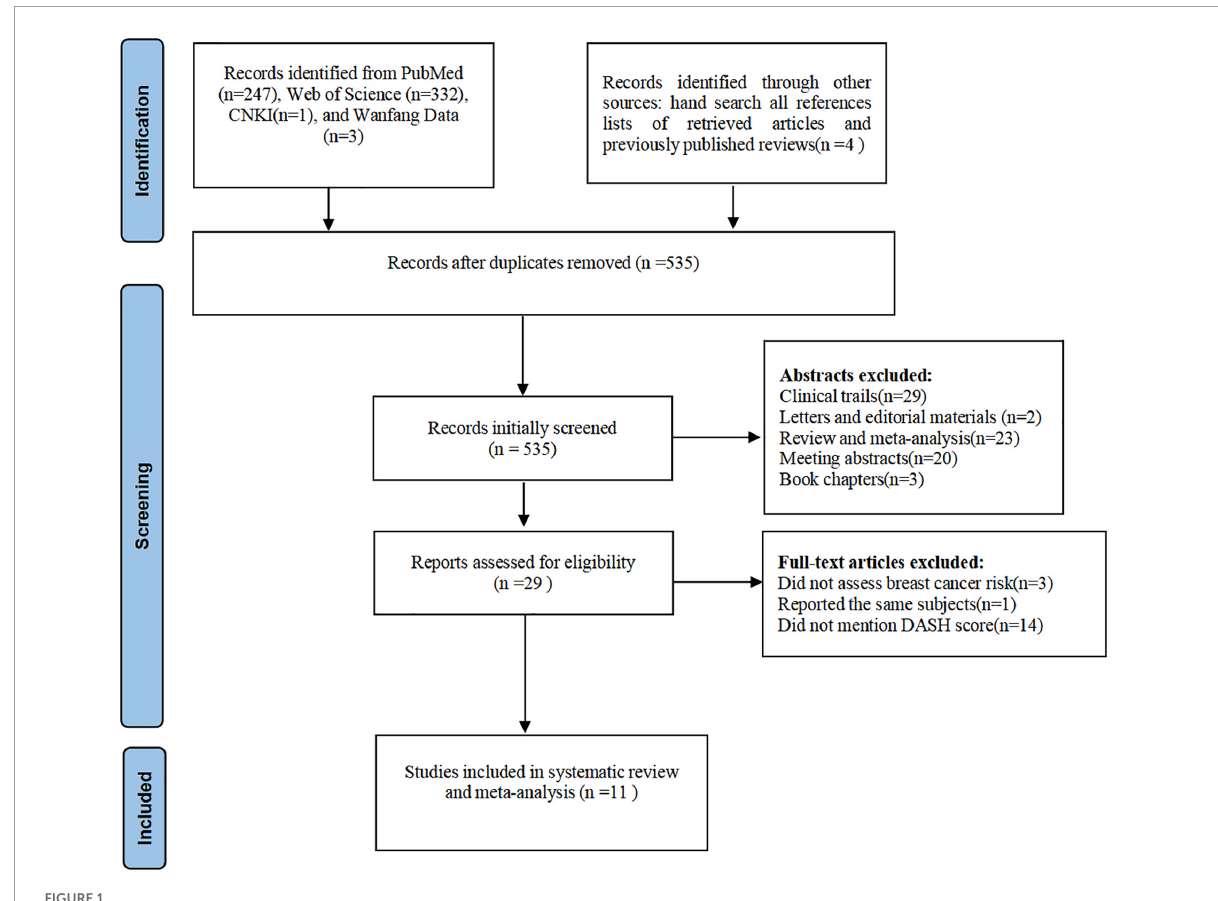
FIGURE1 Flow chart of article screening and selection